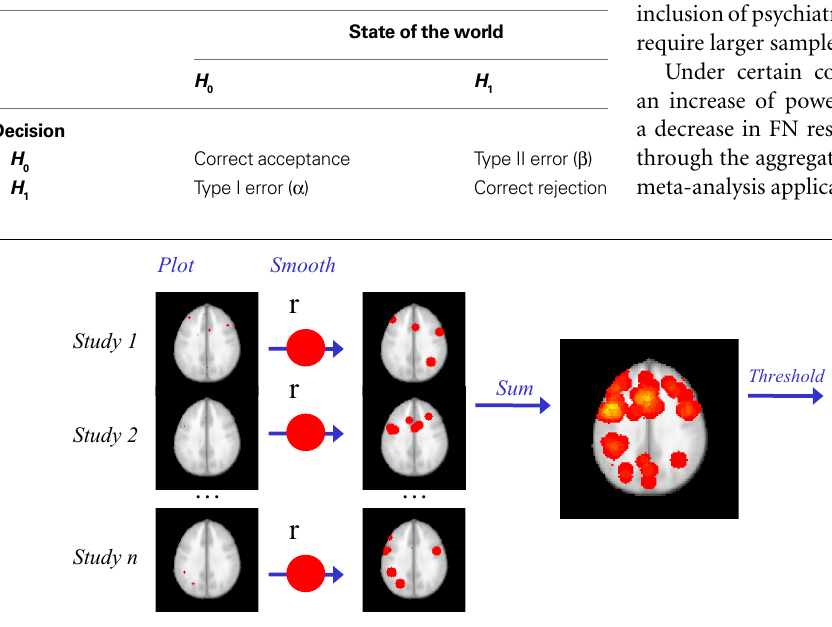
Table 1 | Outcomes of hypothesis